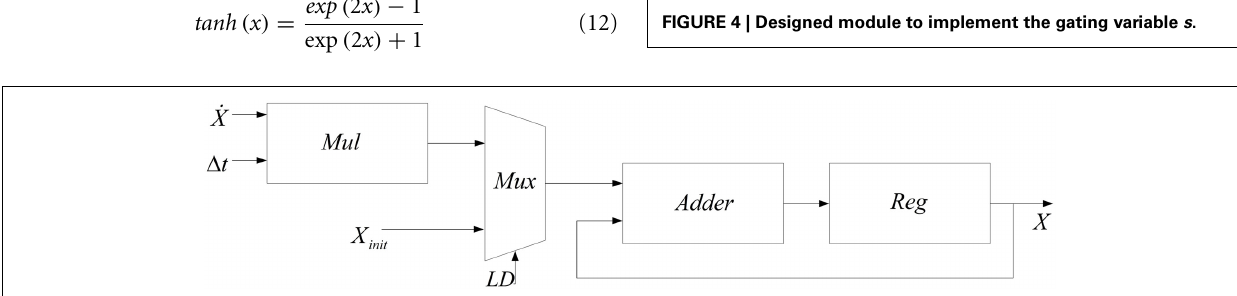
FIGURE 3 | Block diagram of implemented module for calculating the integral